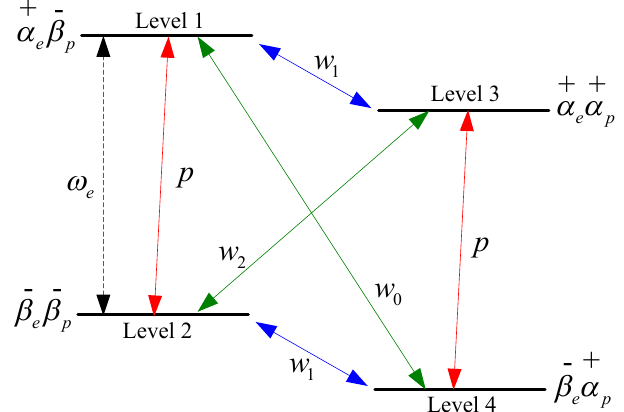
Figure 1. Four-level energy diagram for an electron spin S = 1/2 coupled to a 1 H proton spin I =